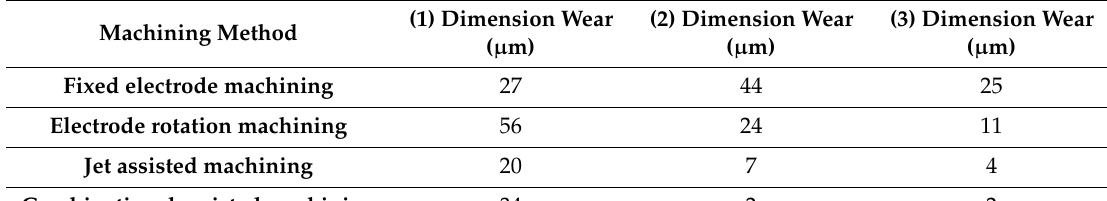
Table 2. Electrode wear conditions of di ff erent machining methods.